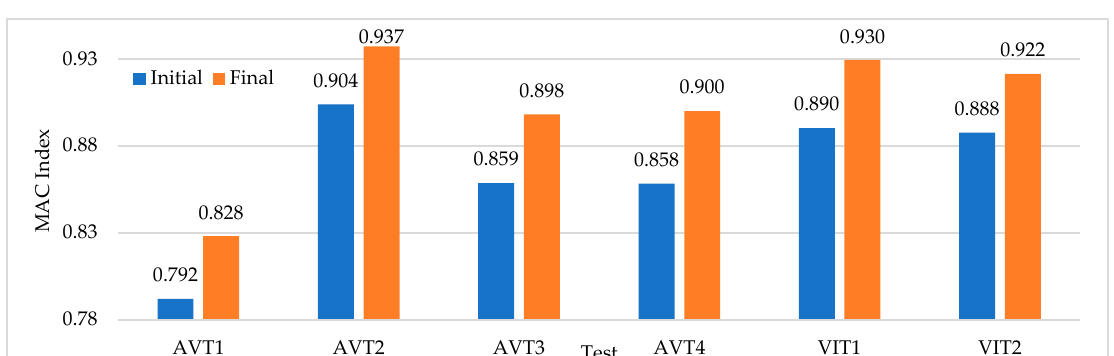
Figure 15. The power spectrum for AVTs and VITs (Units: [m/s 2 ] 2 /Hz).